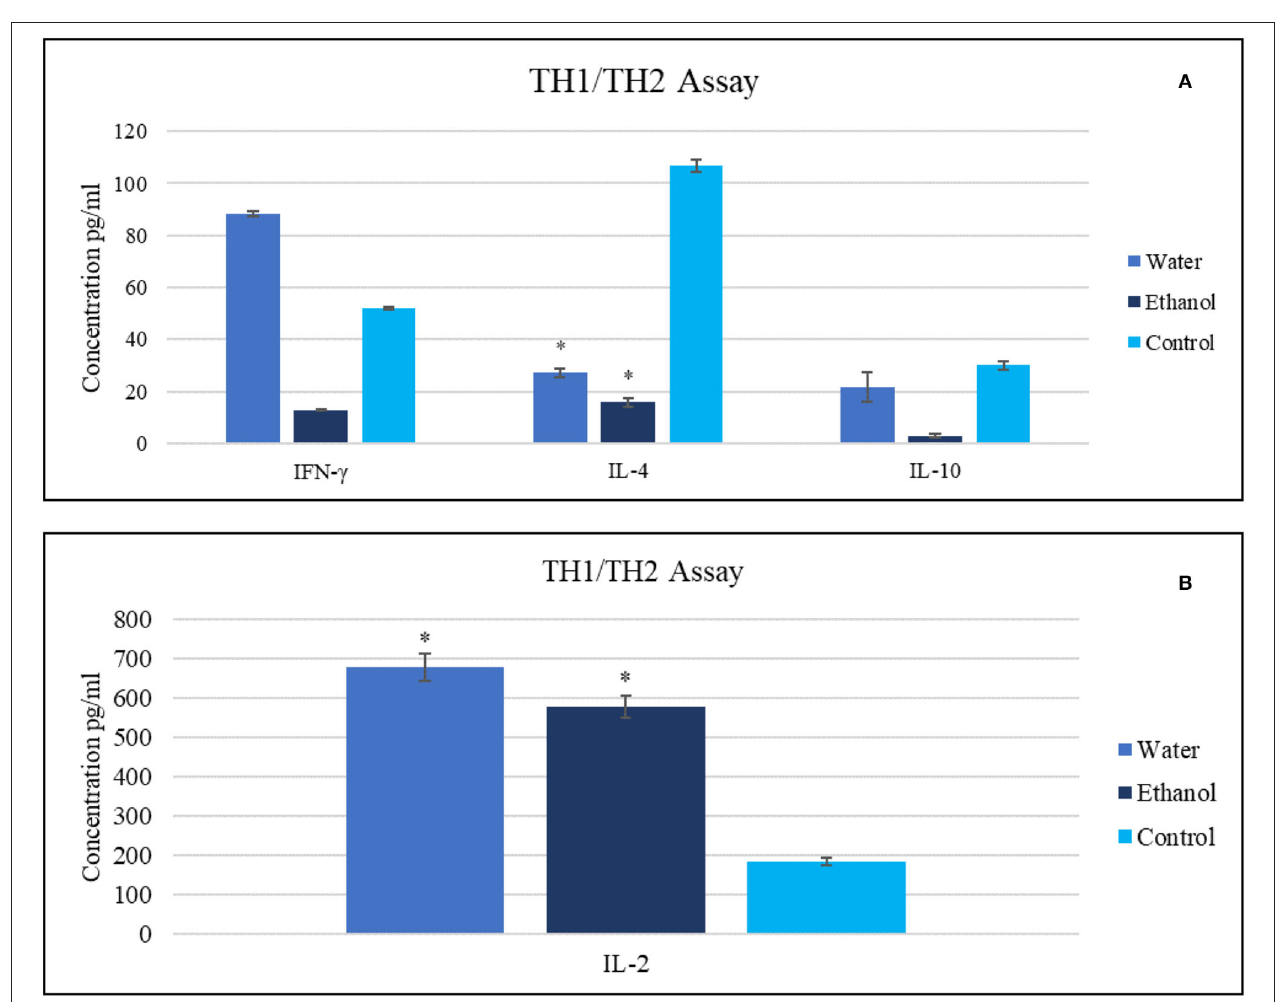
FIGURE 3 | The impact of Gaz alafi extracts (20 mg/ml) on (A) IFN- γ , IL-10, IL-4, and (B) IL-2 levels. Each treatment was performed in duplicate. The highest levels of IFN- γ and IL-2 were detected after aqueous therapy. IFN, interferon; IL, interleukin. * P < 0.05 (statistically significant).